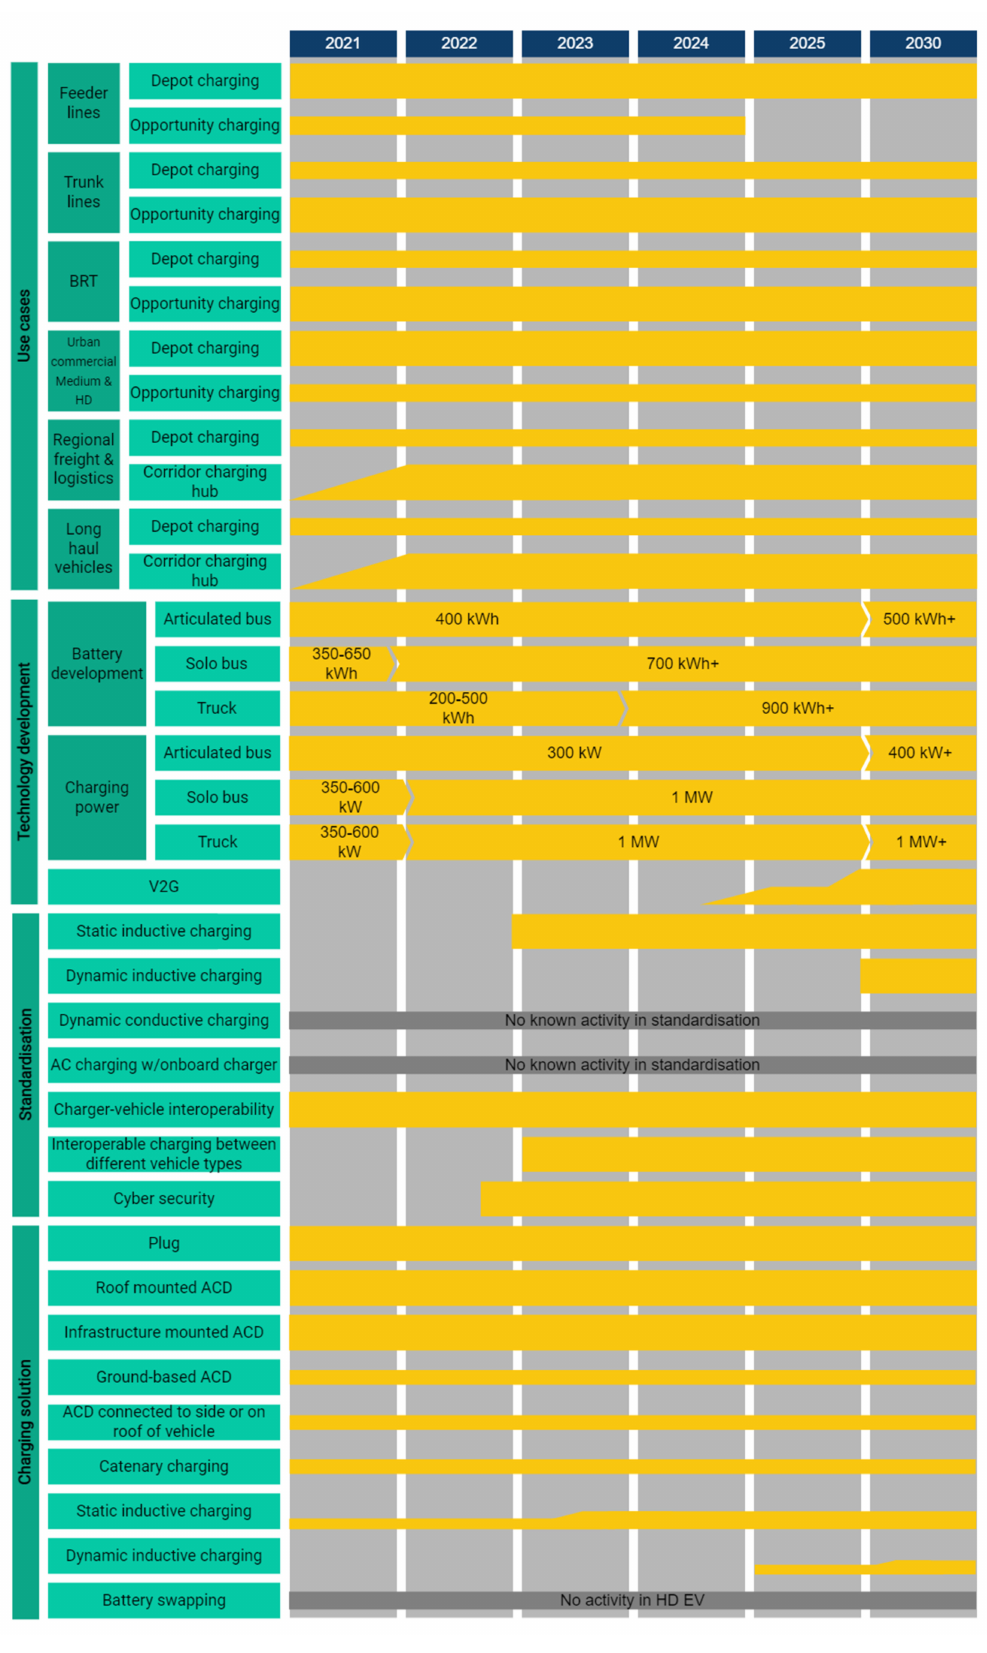
Figure 10. Pre-normative charging technology roadmap for HD-EVs in